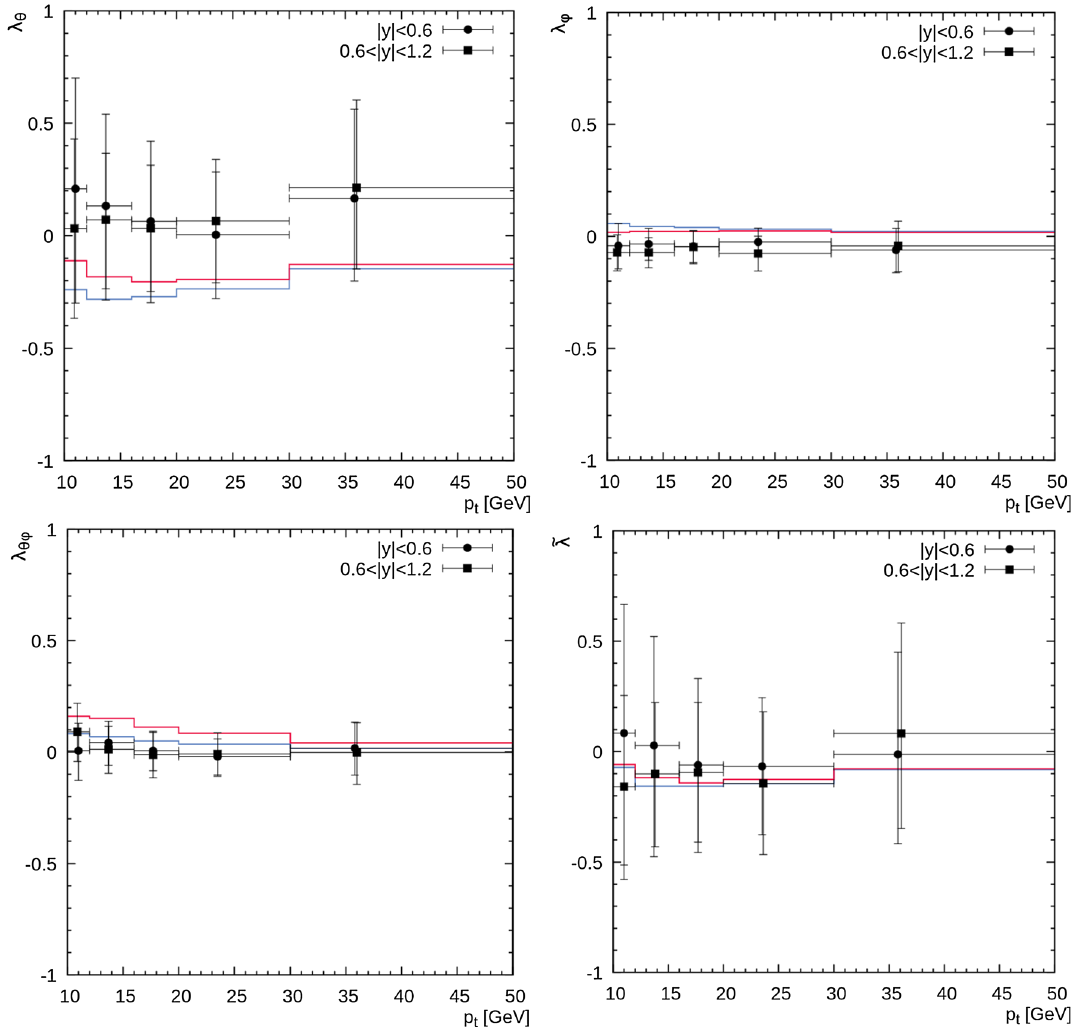
Fig. 12 Thepolarizationparameters λ θ , λ φ , λ θφ and ˜ λ ofthe ϒ( 1 S ) mesonscalculatedinthehelicityframeasfunctionsofitstransversemomentum √ s = 7 TeV. The notation of all histograms is the same as in Fig. 11. The experimental data are from CMS at